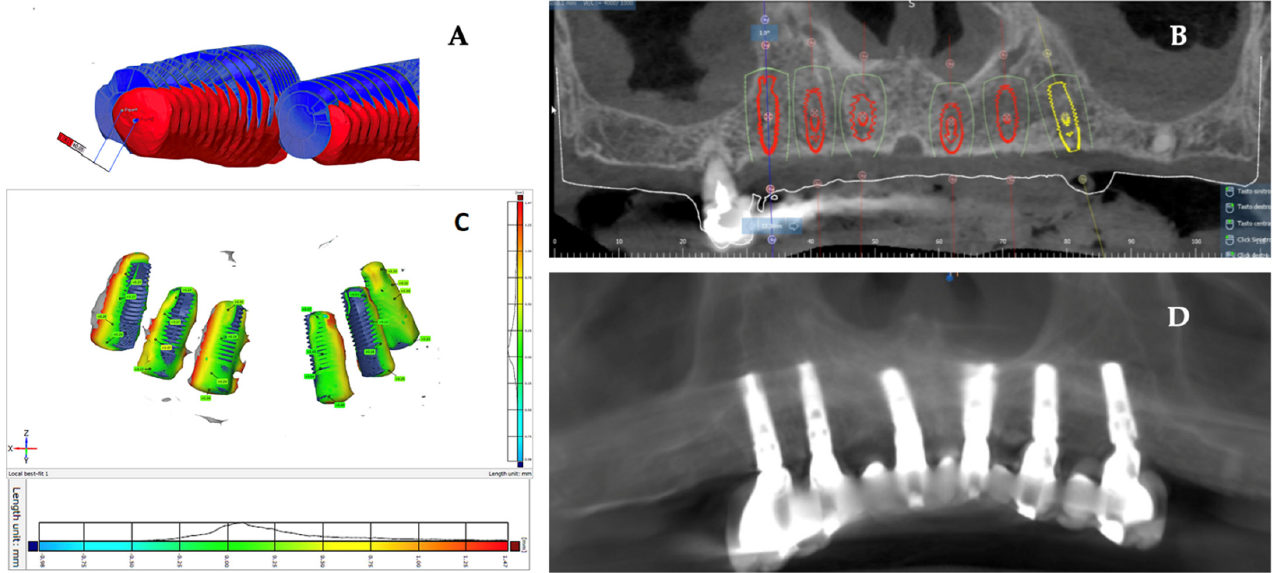
Figure 3. Data analysis: ( A , C ) superimposition of implant planning and postoperative CBCT im- ages. It is possible to graphically see the discrepancy between the inserted and planned implants; ( B , D ) preoperative CBCT images with virtually inserted implants used for fabrication of surgical template; image of the postintervention control CBCT.